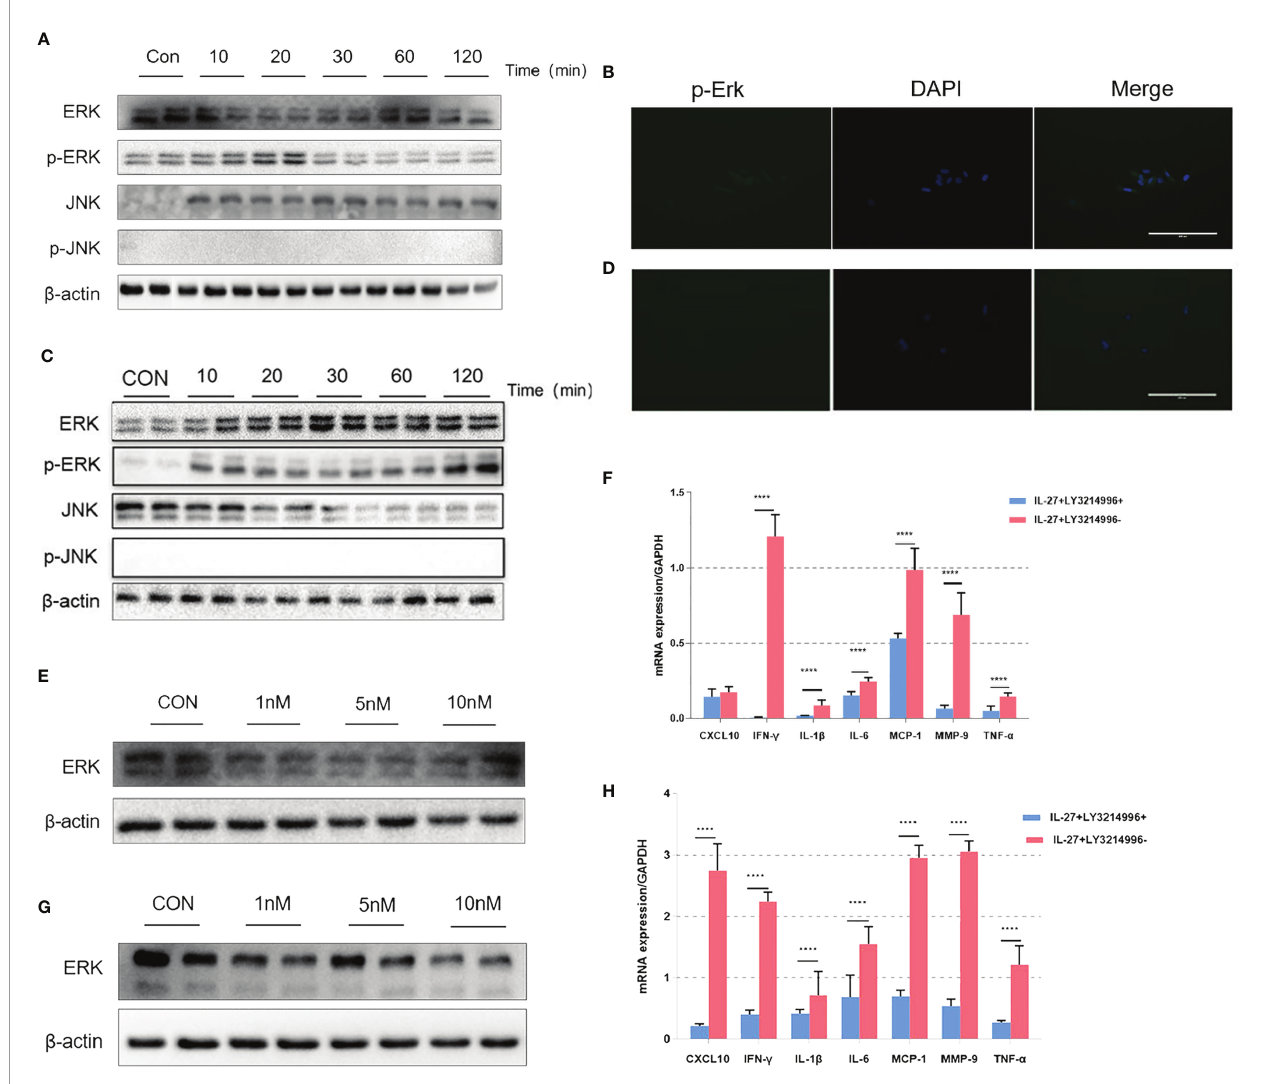
FIGURE 6 | The effects of IL-27 on pro-in fl ammatory effects via a dominant ERK pathway in WISH cells and HMSMC cells. Analysis of WISH cells with regards to activated or tyrosine phosphorylated ERK (p-ERK) and JNK (p-JNK) proteins by western blotting (A) and immuno fl uorescence (B) . The expression of ERK with 0 nM, 5 nM, and 10 nM LY3214996, as determined by western blotting (E) . The relative expression levels of IFN- g after 24 h incubation with 10nM LY3214996, as determined by qRT-PCR (F) . The same analysis has repeated in HMSMC cells (C, D, G, H) . ****P <